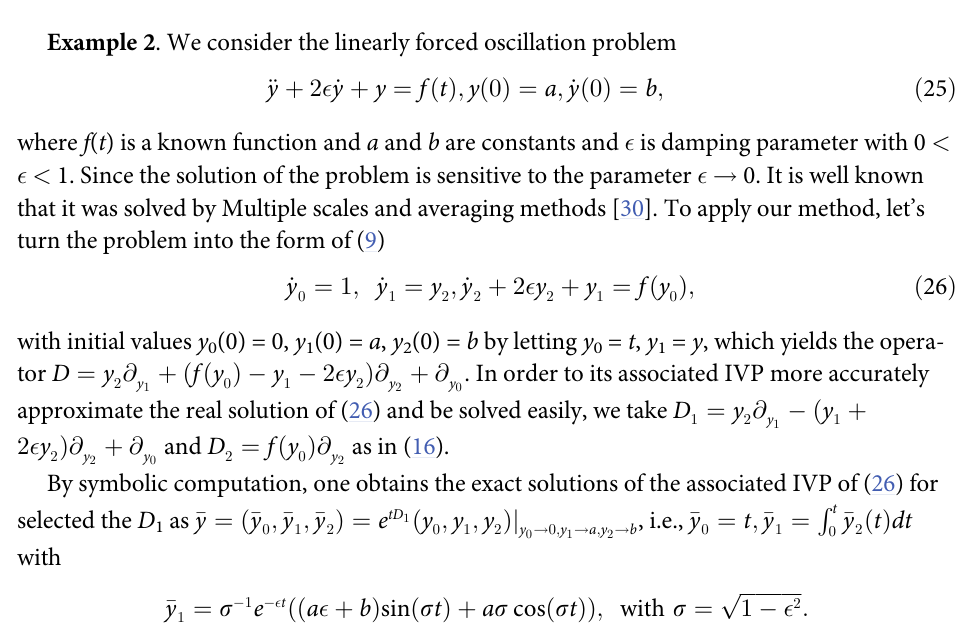
approximating exact ones y 1,2 in Example 1. 1 ; 2